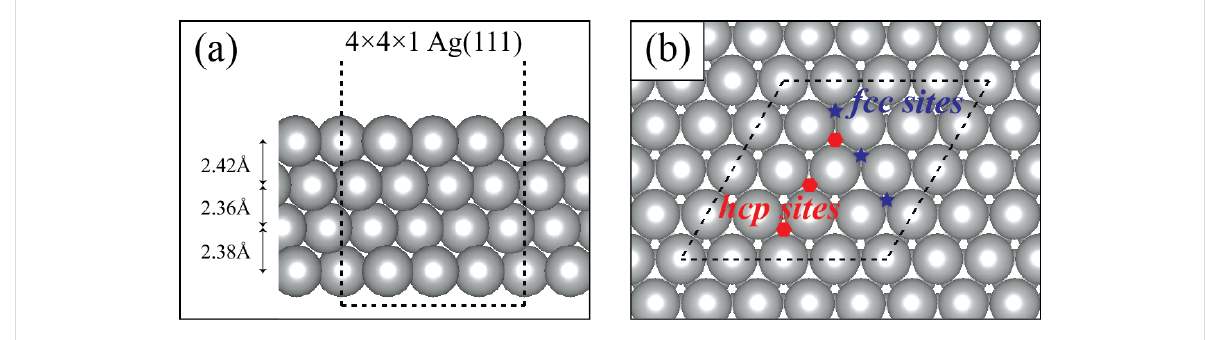
Figure 1: (a) Side view of the Ag(111) supercell structure and (b) top view of the Ag(111) supercell structure with possible oxygen captured sites. Definitions and oxygen binding energies of all sites are given in Table